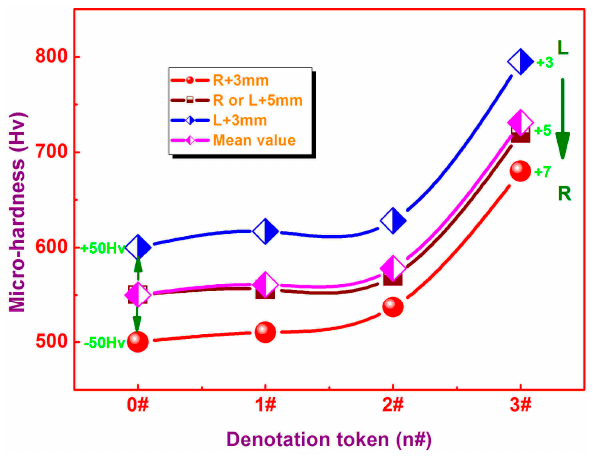
Figure 9. Micro-hardness at different locations for the BMG matrix and different